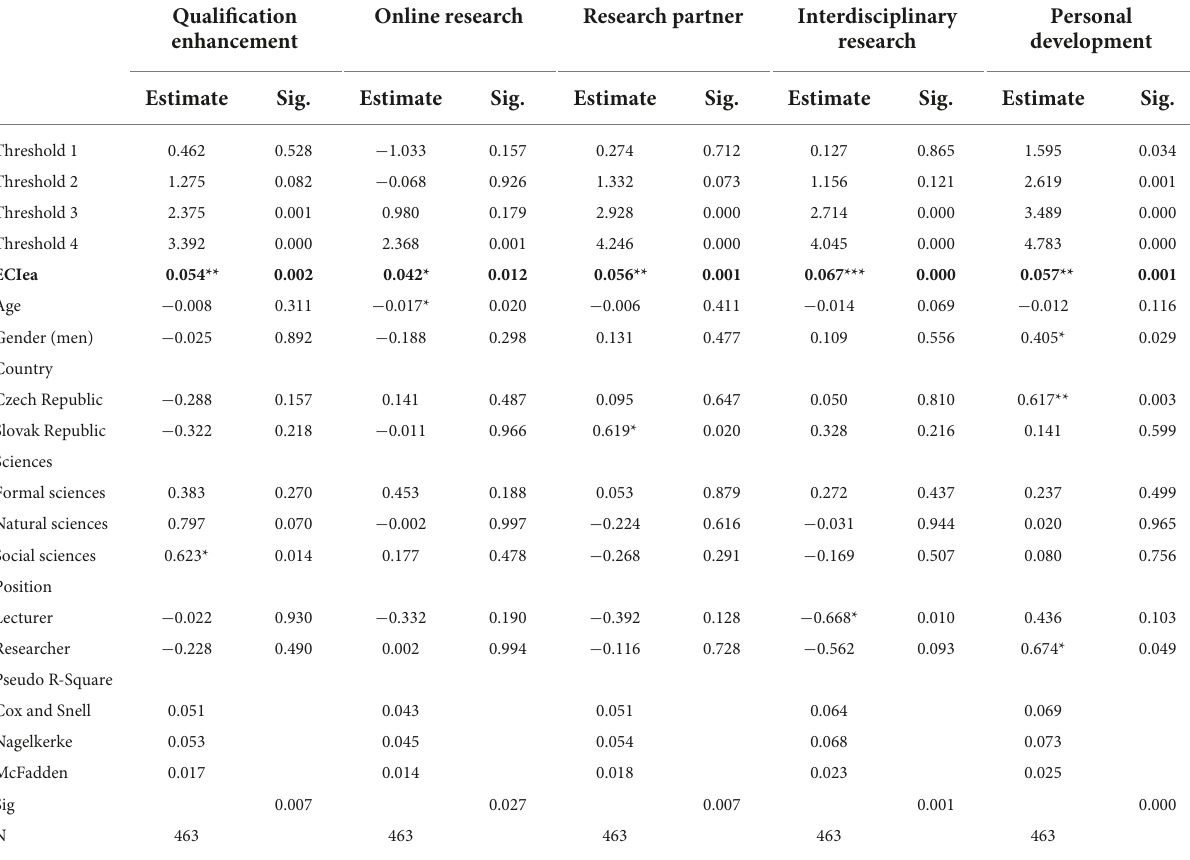
TABLE 7 The Effectiveness/Authenticity component of emotional Creativity (ECIea) predicts motivation for innovative research as a response to online teaching during the COVID-19 epidemic.